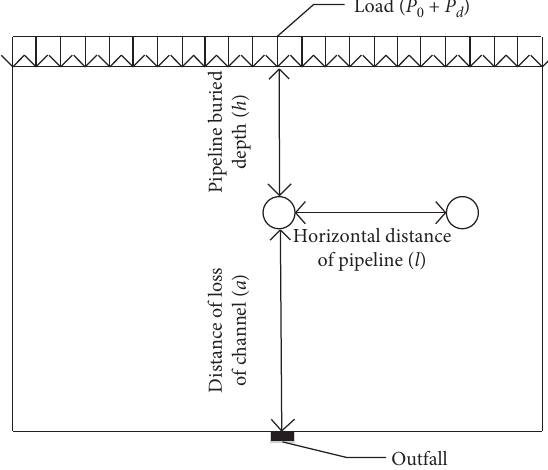
Figure 3: Schematic diagram of the model